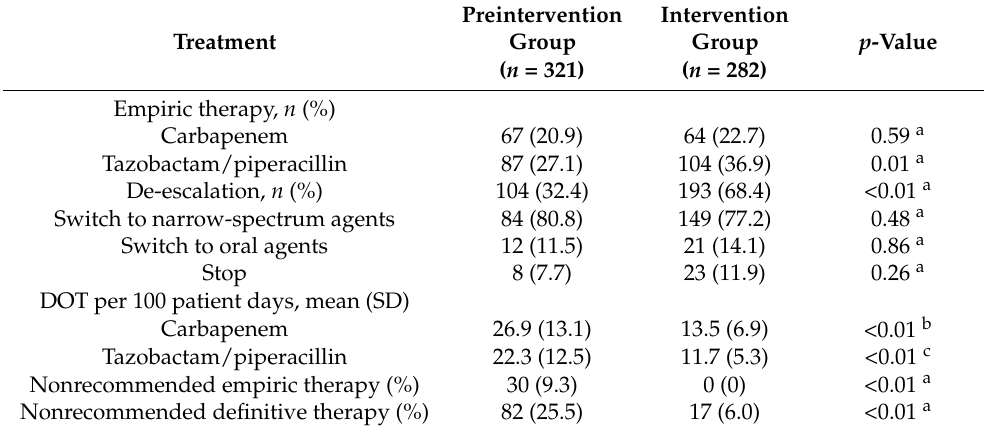
Table 2. Primary outcome assessment.